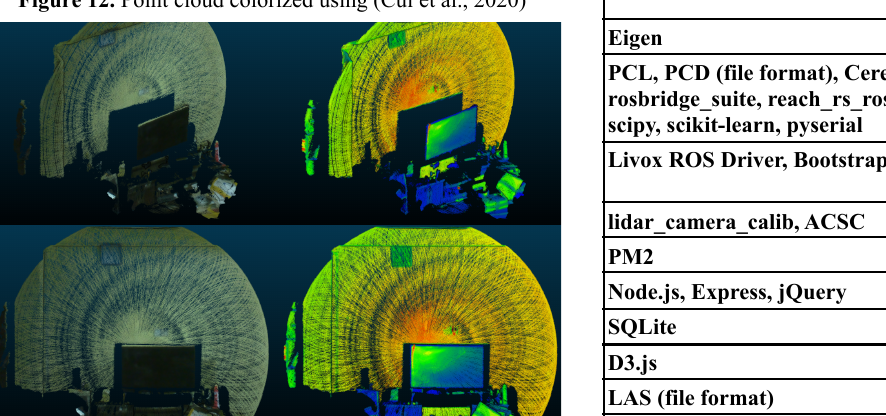
Figure 12. Point cloud colorized using (Cui et al., 2020)